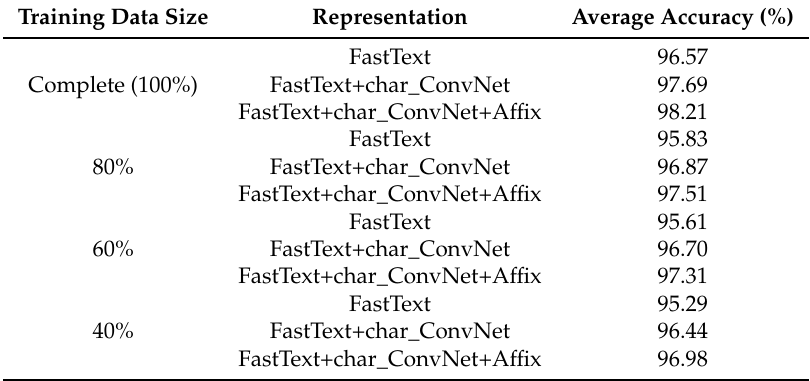
Table 5. Comparing the performance of different word representations on Indian Named Entity Recognition (NER) tasks by varying the training data